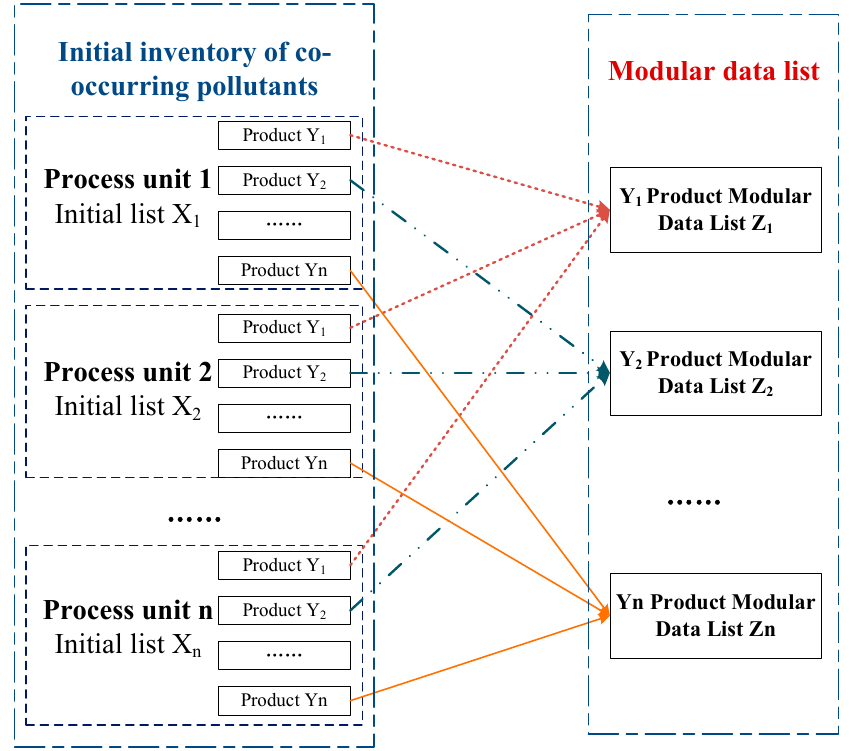
Figure 3. Product modular co-pollutant splitting and recombination principles.